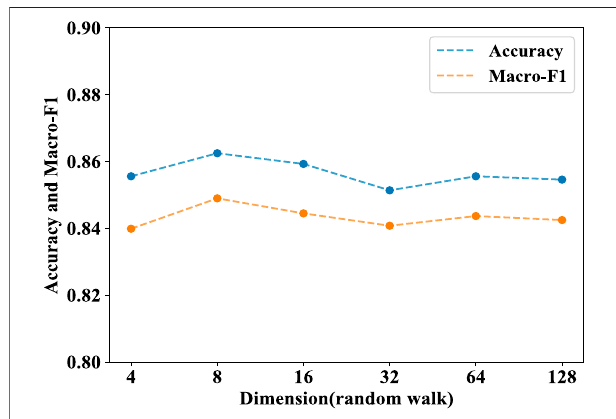
FIGURE 5 | The performance of our method for parameters d rw on the Cora dataset for node classi fi cation task.